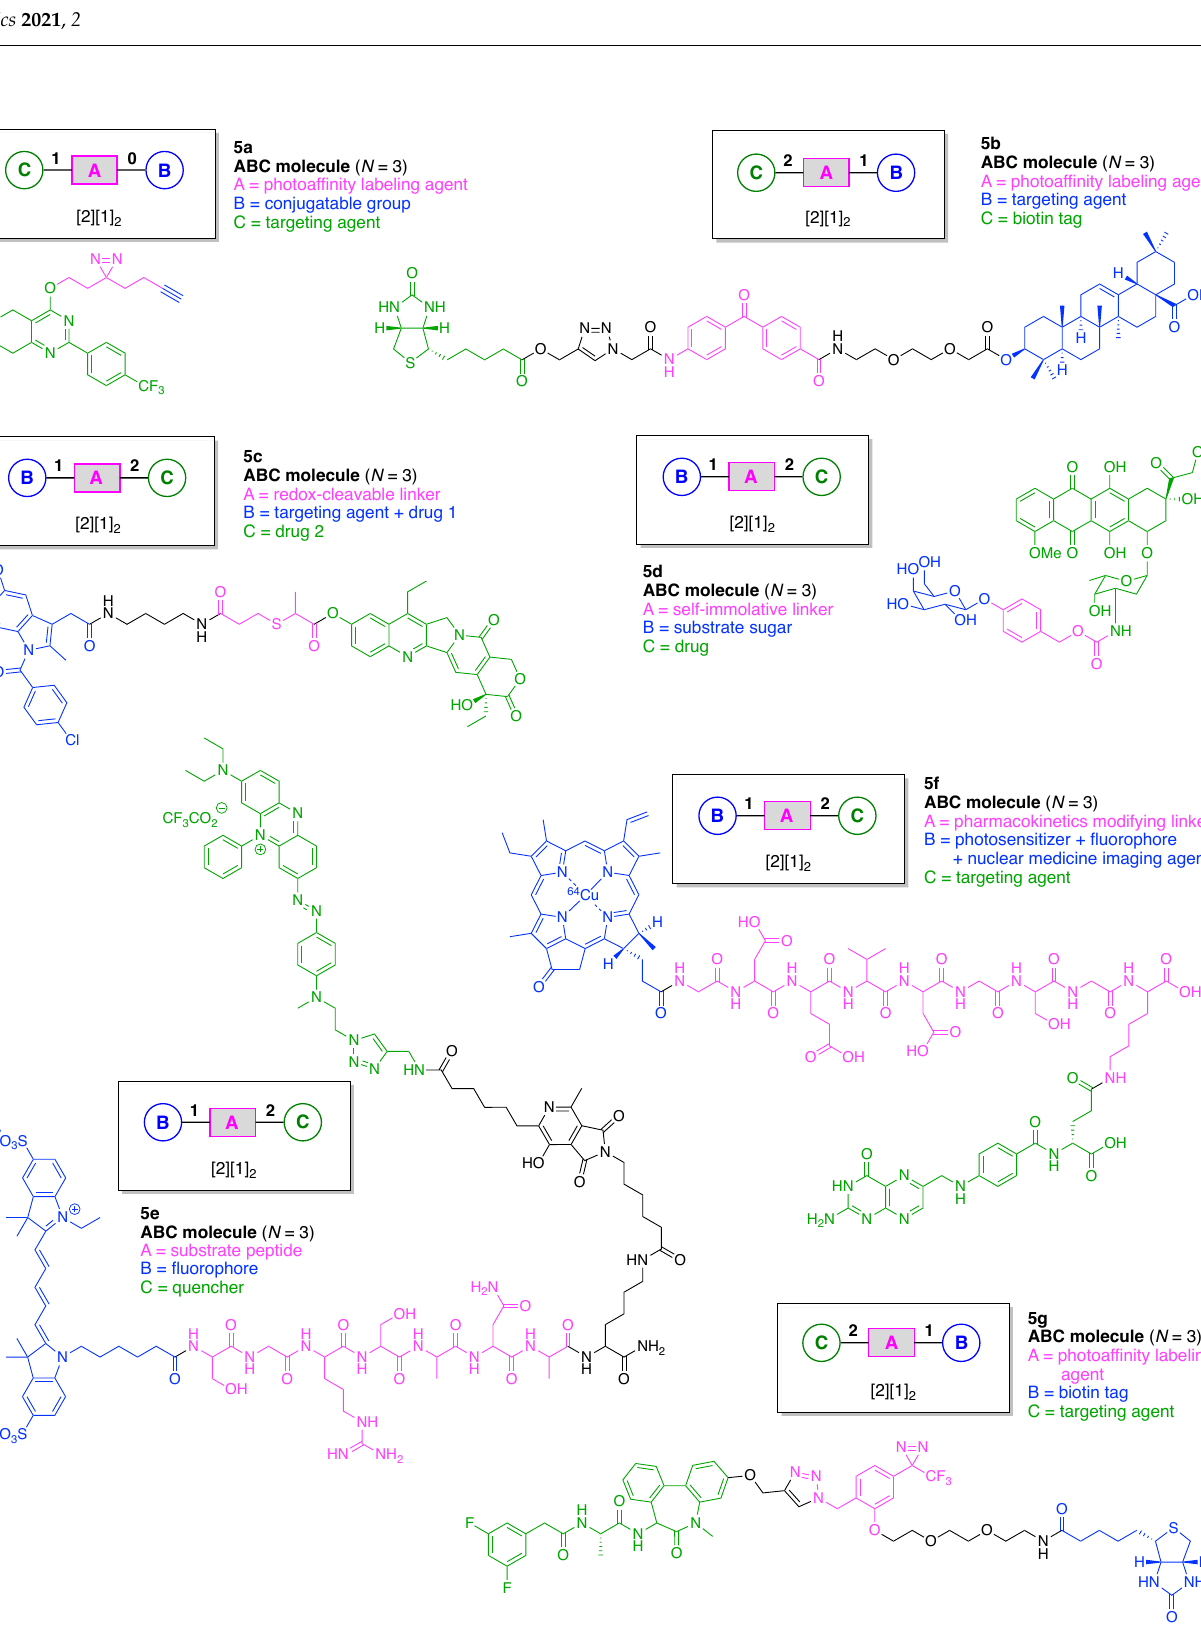
Figure 9. Seven linear multifunctional molecules (no hubs) of graph [2][1] 2 . A trifunctional photoaffinity probe ( 5b ) was developed for investigation of the po- tential target proteins of oleanolic acid (OA). The probe is comprised of three functional components: (A) a benzophenone linker as a PAL agent; (B) OA as a targeting agent for complementary proteins, and (C) a biotin tag [47].